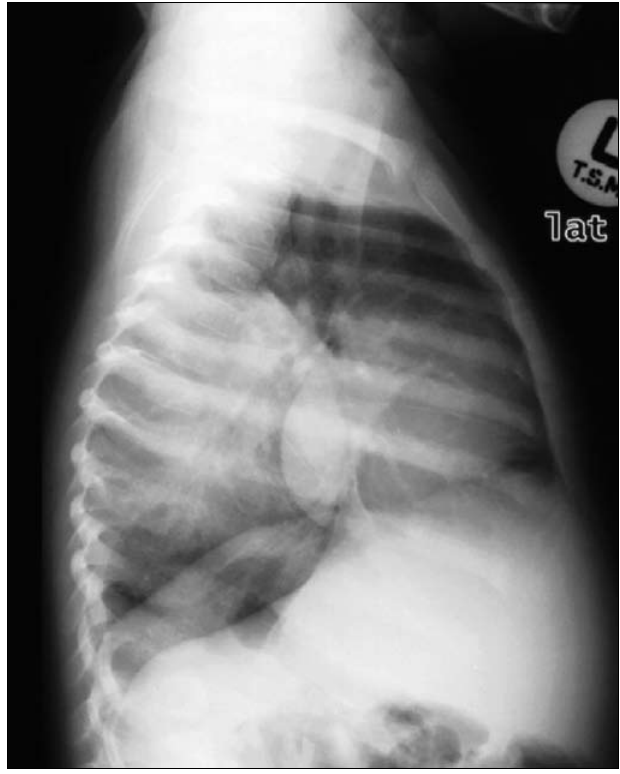
Fig. 2. Lateral CXR confirms a posterior mediastinal mass.